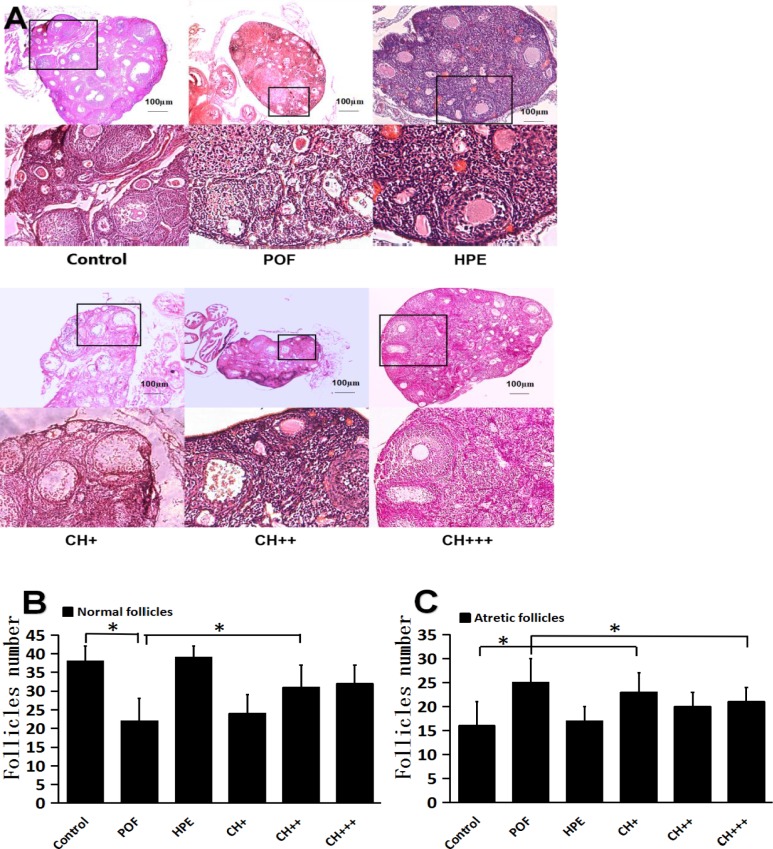
A. Histological comparison of ovarian morphology. B. Comparison of the total number of classified follicles. C. Comparison of the total number of atretic follicles.Compared with the control group, the number of normal follicles in POF, CH +, CH ++ and CH +++ groups was significantly decreased (* P <0.05 vs. the control group); Compared with the POF group, the number of normal follicles in HPE, CH ++ and CH +++ group was significantly increased (* P <0.05 vs. the POF group); Compared with the Control group, the number of atretic follicles in POF and CH + groups was increased significantly (*P <0.05 vs. the control group); Compared with the POF group, the number of atretic follicles in the HPE, CH ++ and CH +++ groups was significantly reduced (*P <0.05 vs. the POF group).